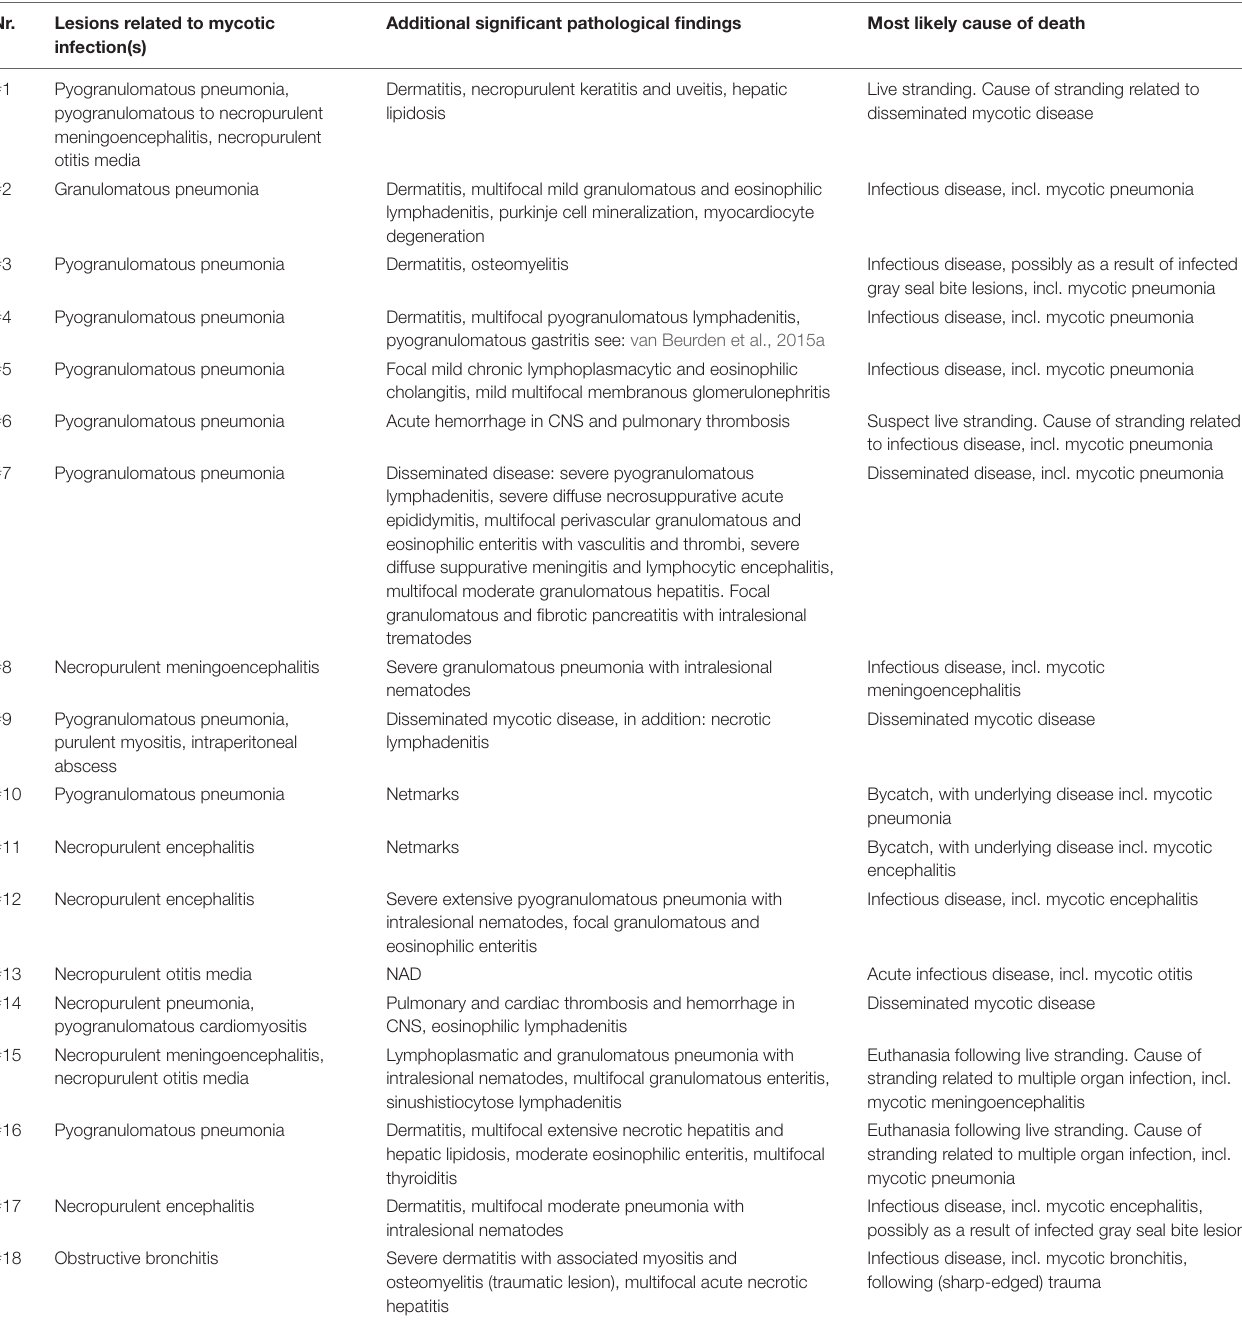
TABLE 2 | An overview of lesions related to mycotic infections, additional significant pathological findings and most likely cause of death.